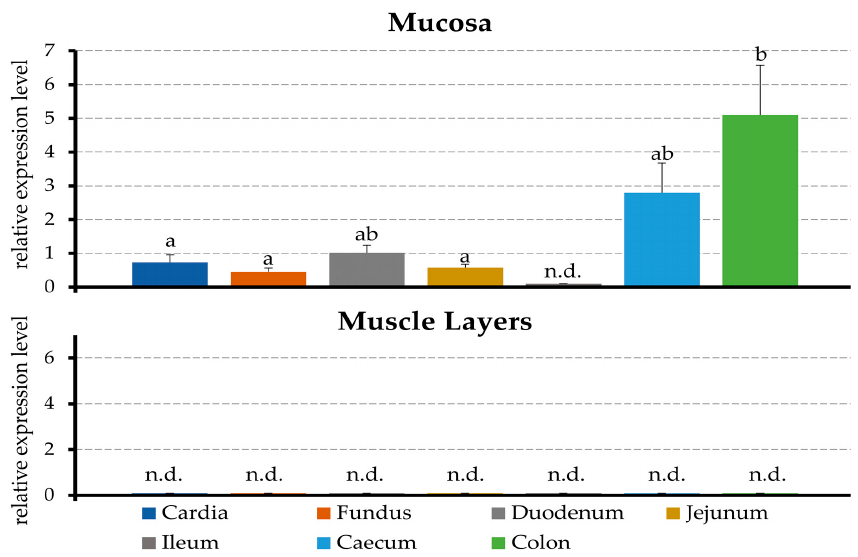
Figure 1. Relative mRNA expression of TRPA1 in the mucosa of the stomach (fundus and cardia), duodenum, jejunum, ileum, caecum and colon, and associated muscle layers of four young pigs from a controlled in-house study. Normalization was performed to the reference genes ACTB, GAPDH and YWHAZ, with scaling to the mean values of all of the samples. The letters above the bars indicate statistically significant differences between those bars that do not share a letter ( p < 0.05) (n.d. = not detected). Int. J. Mol. Sci. 2021 , 22 , x FOR PEER REVIEW